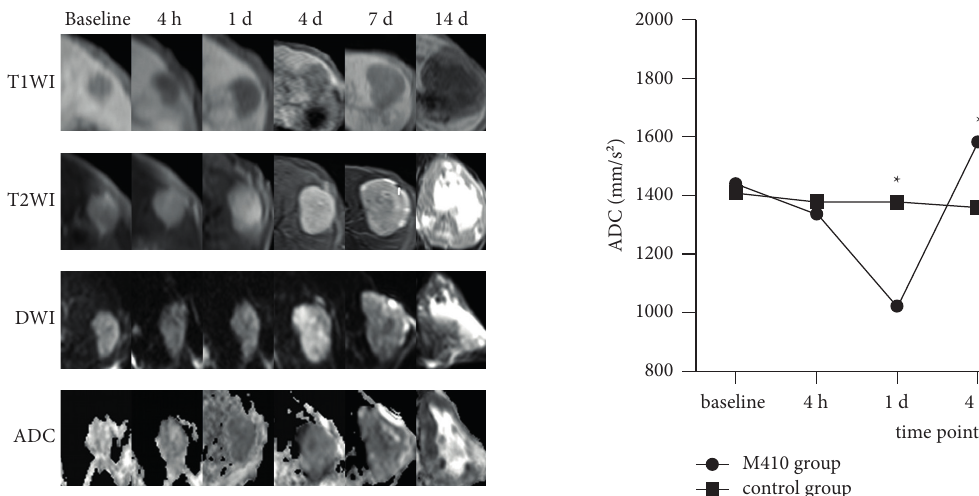
Figure 2: Findings in the control group. The tumor remained hypointense on T1-weighted imaging (T1WI) at all time points. Similarly, the tumor was hyperintense on T2-weighted imaging (T2WI) throughout the experiment, with obvious liquefaction necrosis in the center of the tumor at day 14. At baseline, the tumor was hyperintense on diffused weighted-imaging (DWI), from 4h to day 14. The DWI signal of the tumor gradually increased compared with the baseline, and the apparent diffusion coefficient (ADC) value of the entire tumor decreased from the baseline till day 4, after which it increased continuously until day 14 due to the liquefaction necrosis in the center of the tumor. However, the ADC value of the solid component of the tumor decreased gradually throughout the experiment.